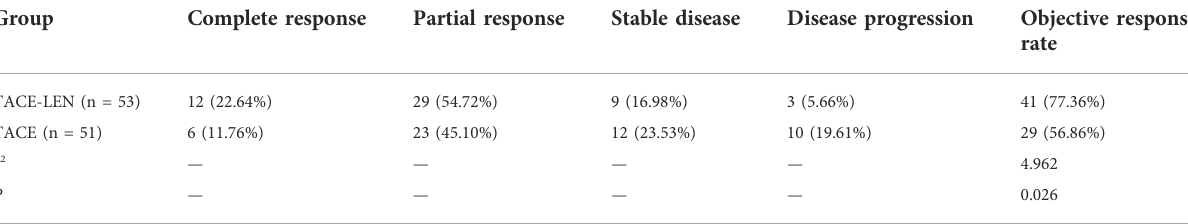
TABLE 2 Comparison of the clinical ef fi cacy between the two groups. Group